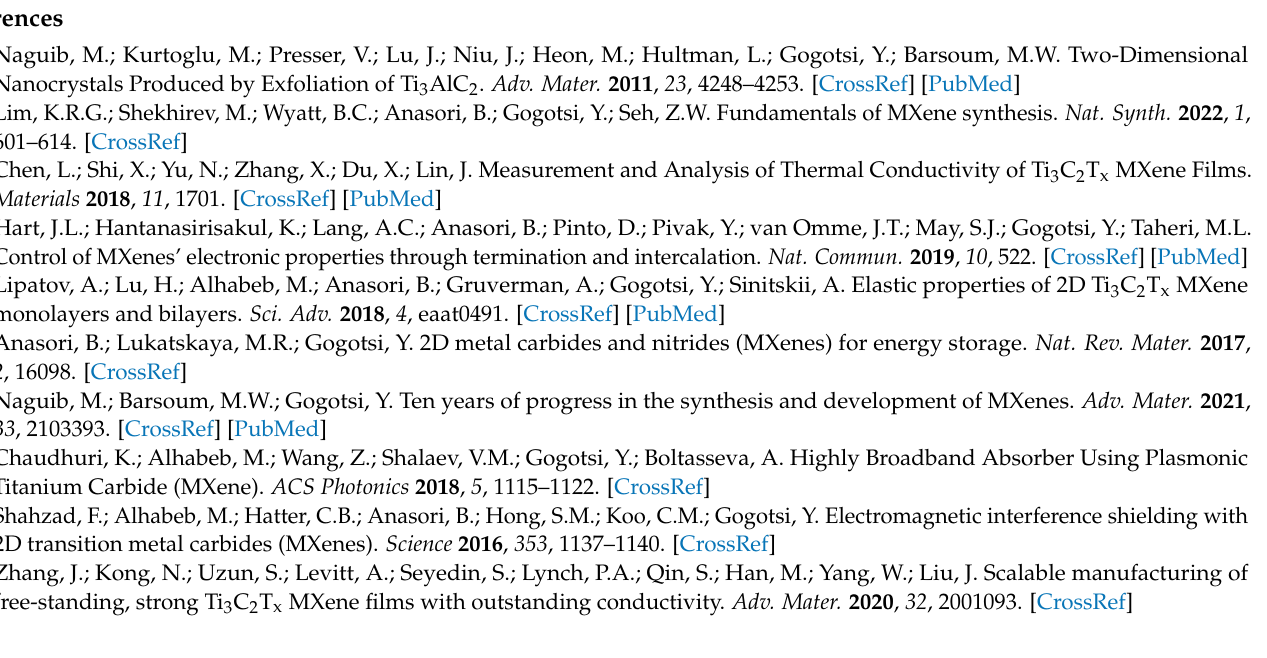
Figure S2: (a) FT-IR spectra of DC, pristine MXene and MX@DC-10 films and (b) Digital photograph Figure S4: EMI SE of reflection (SER) and absorption (SEA) of the MX@DC-x films as a function of DC concentration. Table S1: EDS of MAX and MXene. Table S2: I D /I G ratio of MXene and MX@DC-x films. Table S3: A summary on tensile and strain of the pure and functionalized Ti 3 C 2 T x (MXene) films. Table S4: A summary on EMI SE of the pure and functionalized Ti 3 C 2 T x (MXene) films. Author Contributions: Conceptualization, S.K. (Soyeon Kim); methodology, S.K. (Soyeon Kim)